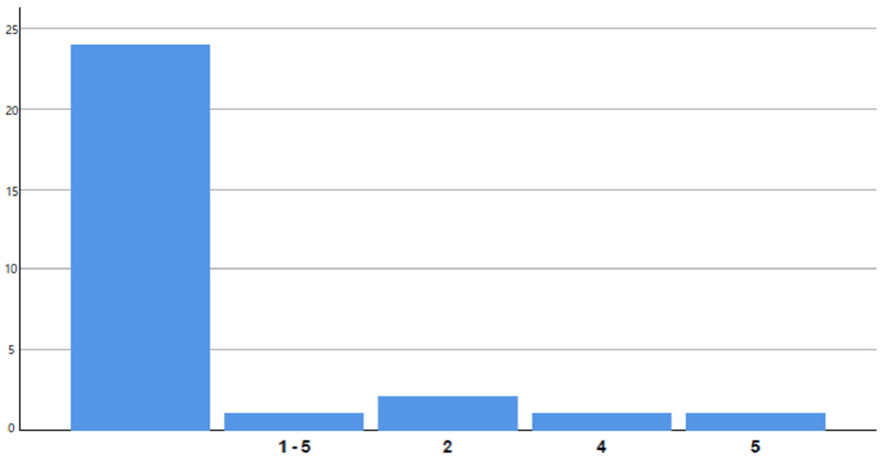
Figure 9. EUS-GG endoscopist’s experience.